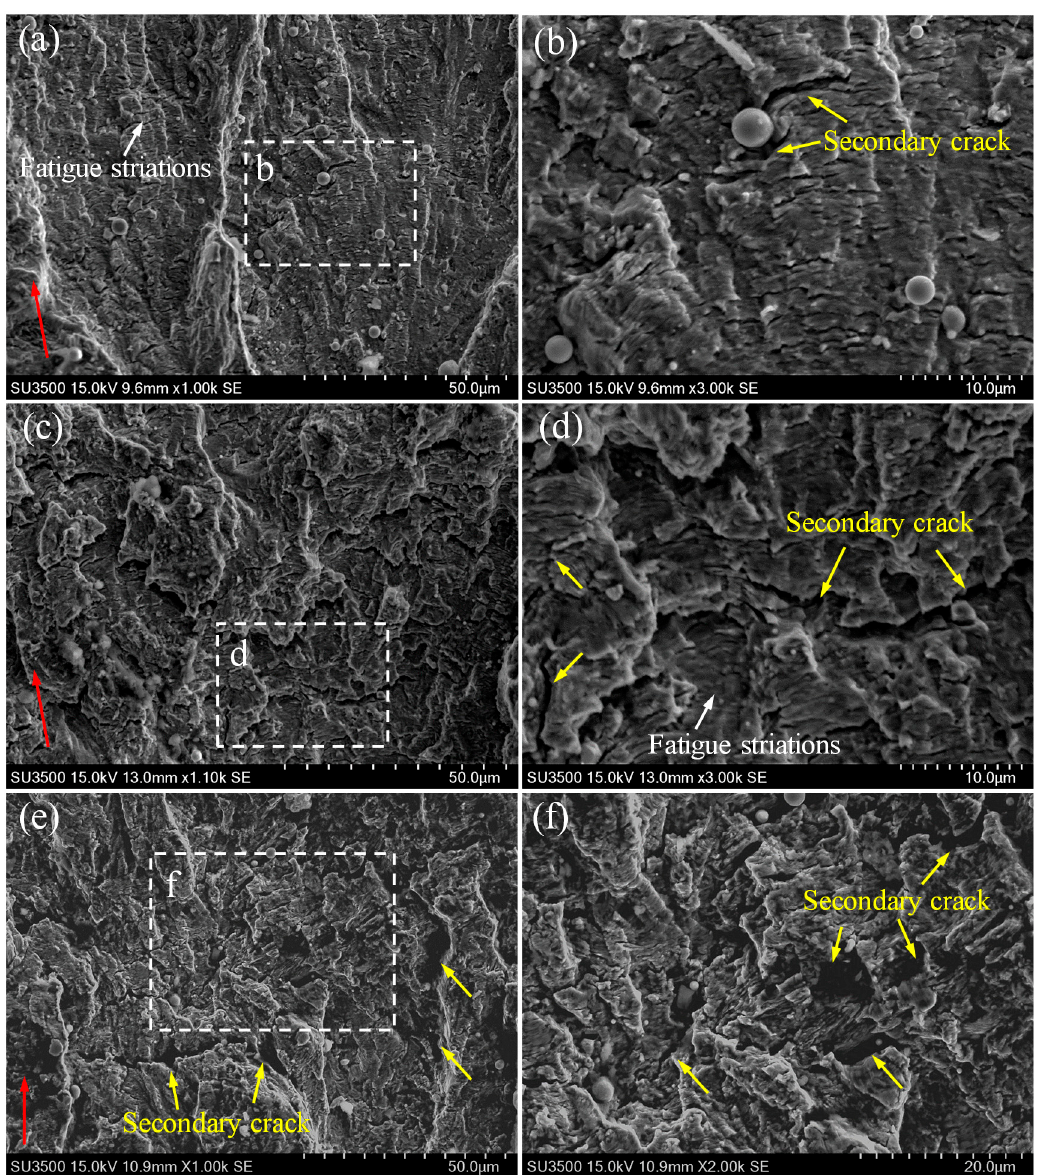
Figure 5. Fatigue fracture surfaces of ( a , b ) BM, ( c , d ) HAZ and ( e , f ) WM specimens at Δ K value of approximately 33 MPa·m 1/2 . Typically, the red arrows represent the crack growth direction, the white arrows represent the fatigue striations, and the yellow arrows indicate the secondary cracks. Some secondary cracks perpendicular to fatigue striations can be found in ( d – f ).